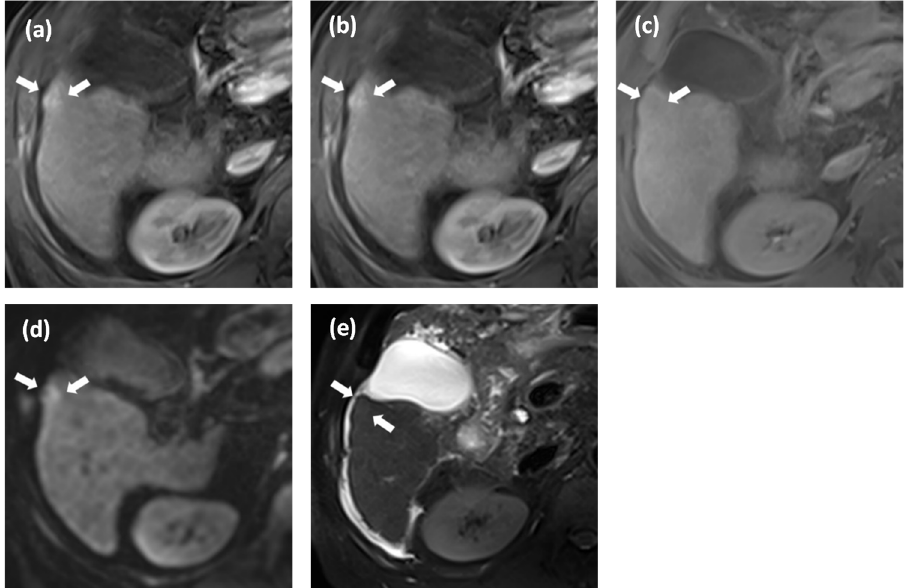
Figure 3. Histologically proven hepatocellular carcinoma (HCC) in a 67-year-old man with hepati-tis-B-virus-related liver cirrhosis. Gadoxetate disodium-enhanced MRI ( a – e , arrow) shows a 10-mm observation with nonrim arterial phase hyperenhancement ( a ) and lack of definitive nonperipheral washout or enhancing capsule on portal venous ( b ) and transitional phase image ( c ). Thus, it is categorized as LR3 according to major features only. The observation shows restricted diffusion (b = 800 s/mm 2 ; ( d )) and mild T2 hyperintensity ( e ). Our decision tree algorithm classifies this nodule as HCC.